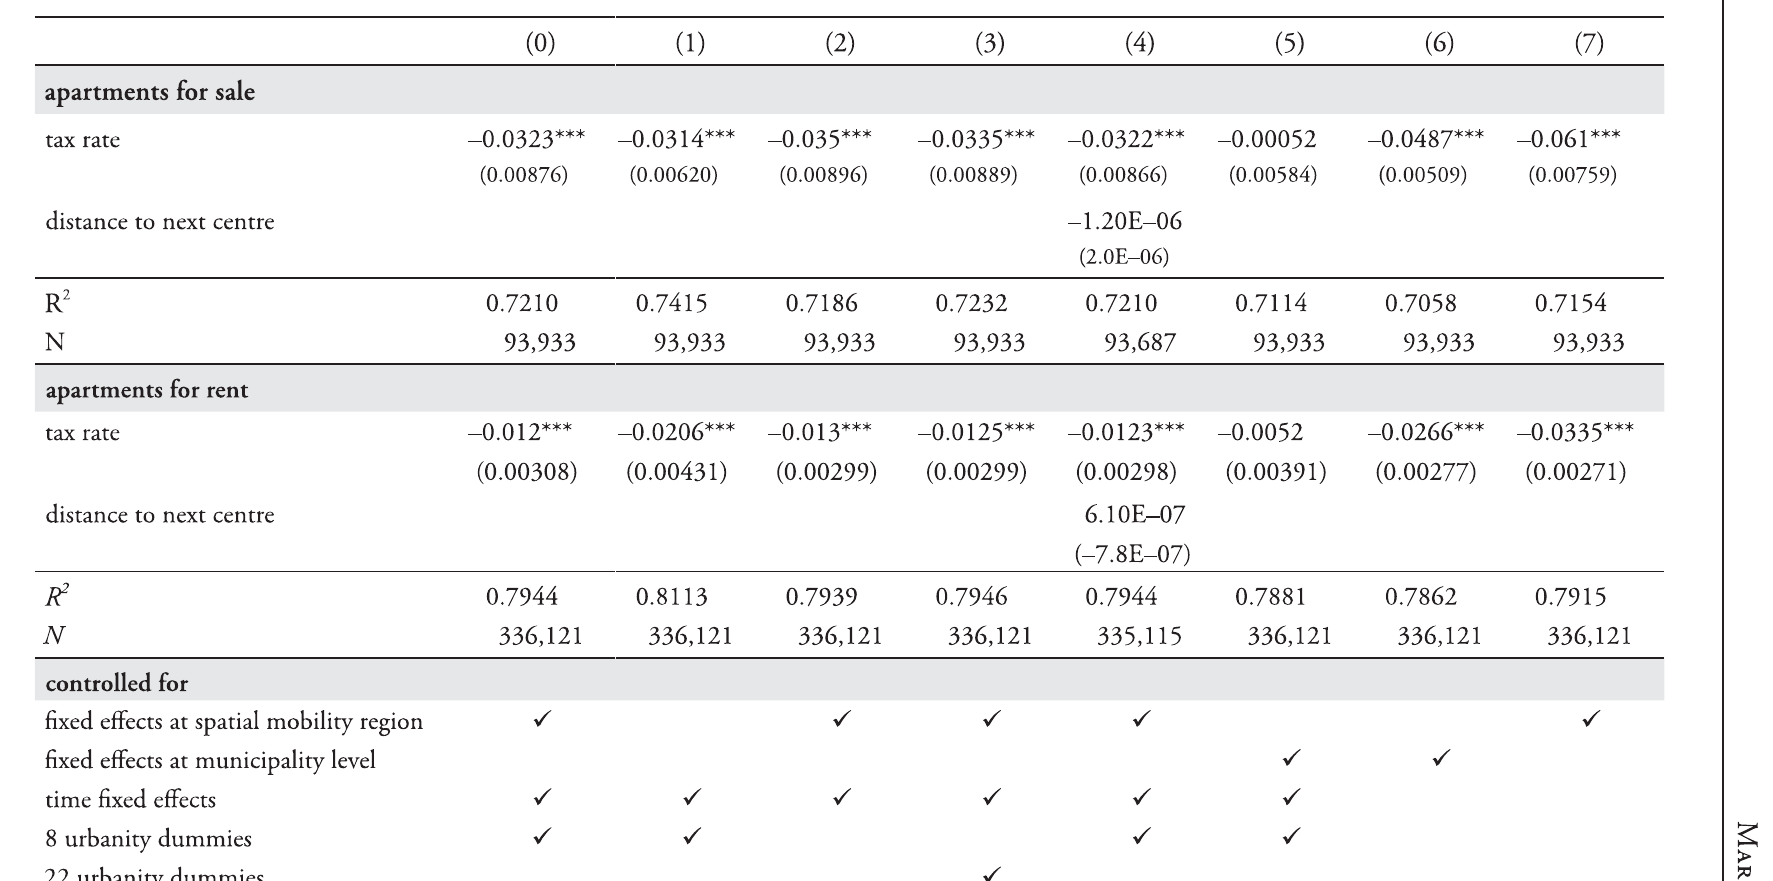
Table 4: Robustness Tests of Baseline